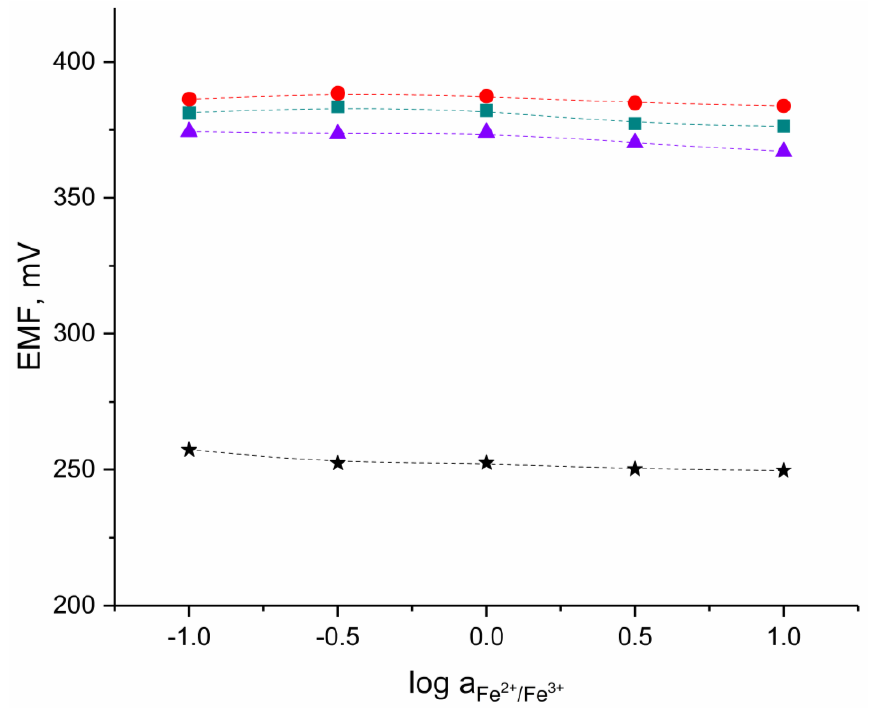
Figure 5. Redox test conducted in the Fe 2+ / Fe 3+ redox couple solutions for ⚫ -GC/hIrO 2 /H + -ISM, ◼ -GC/hIrO 2 -NTs/H + -ISM, -GC/hIrO 2 -NTs-POT/H + -ISM and -GC/H + -ISM electrode.